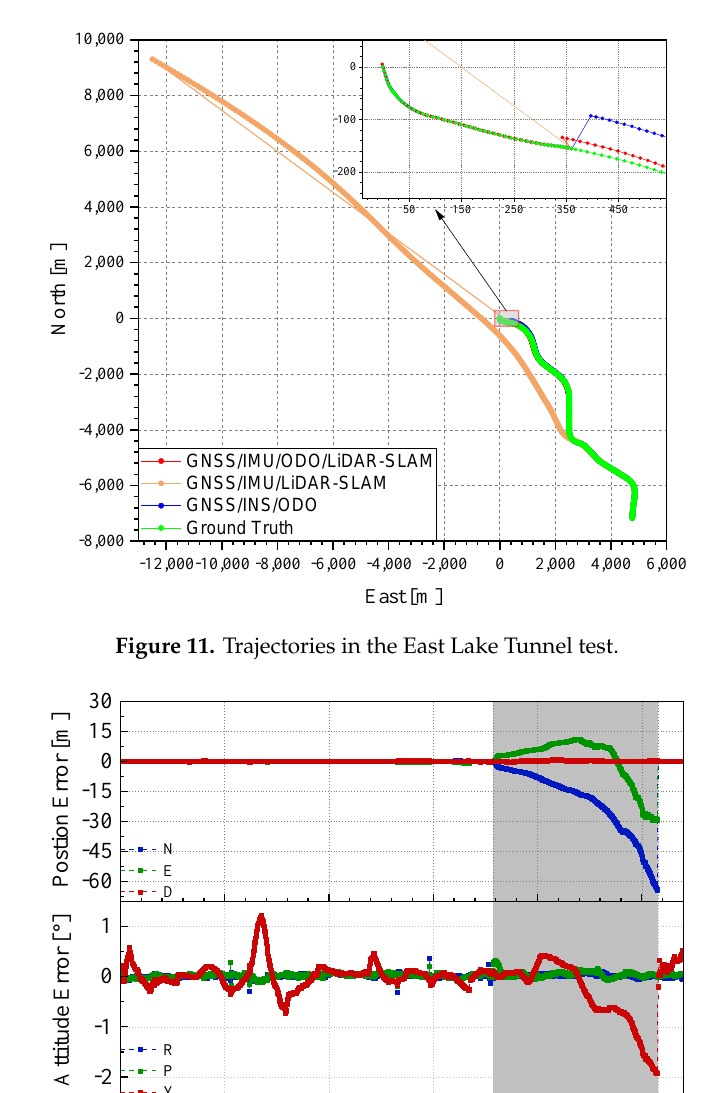
Figure 13. GNSS/IMU/ODO/LiDAR-SLAM navigation errors in the East Lake Tunnel test.